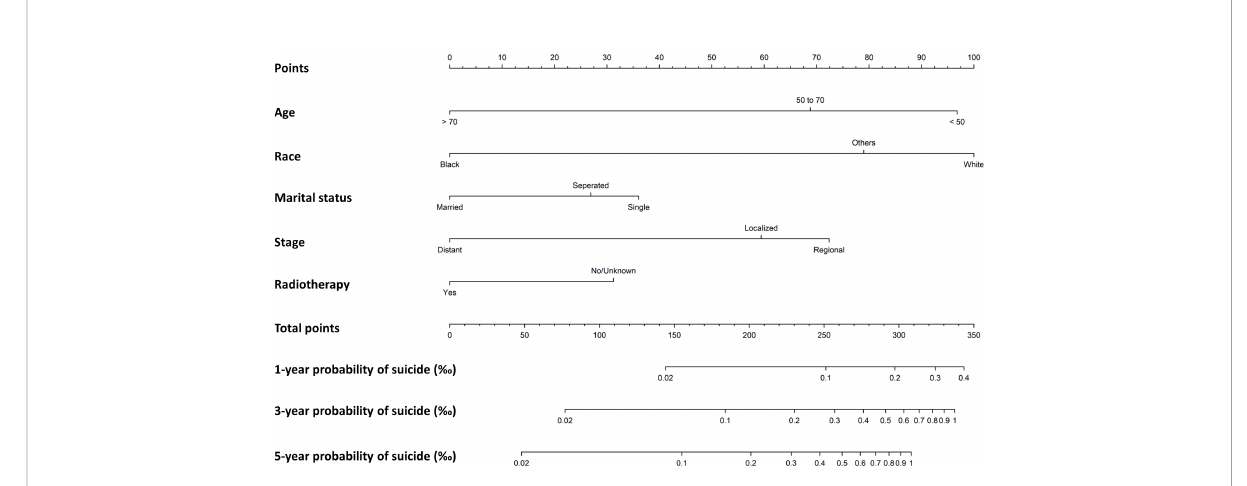
FIGURE 3 Nomogram to predict fi rst-, three- and fi ve-year probabilities of suicide for female breast cancer